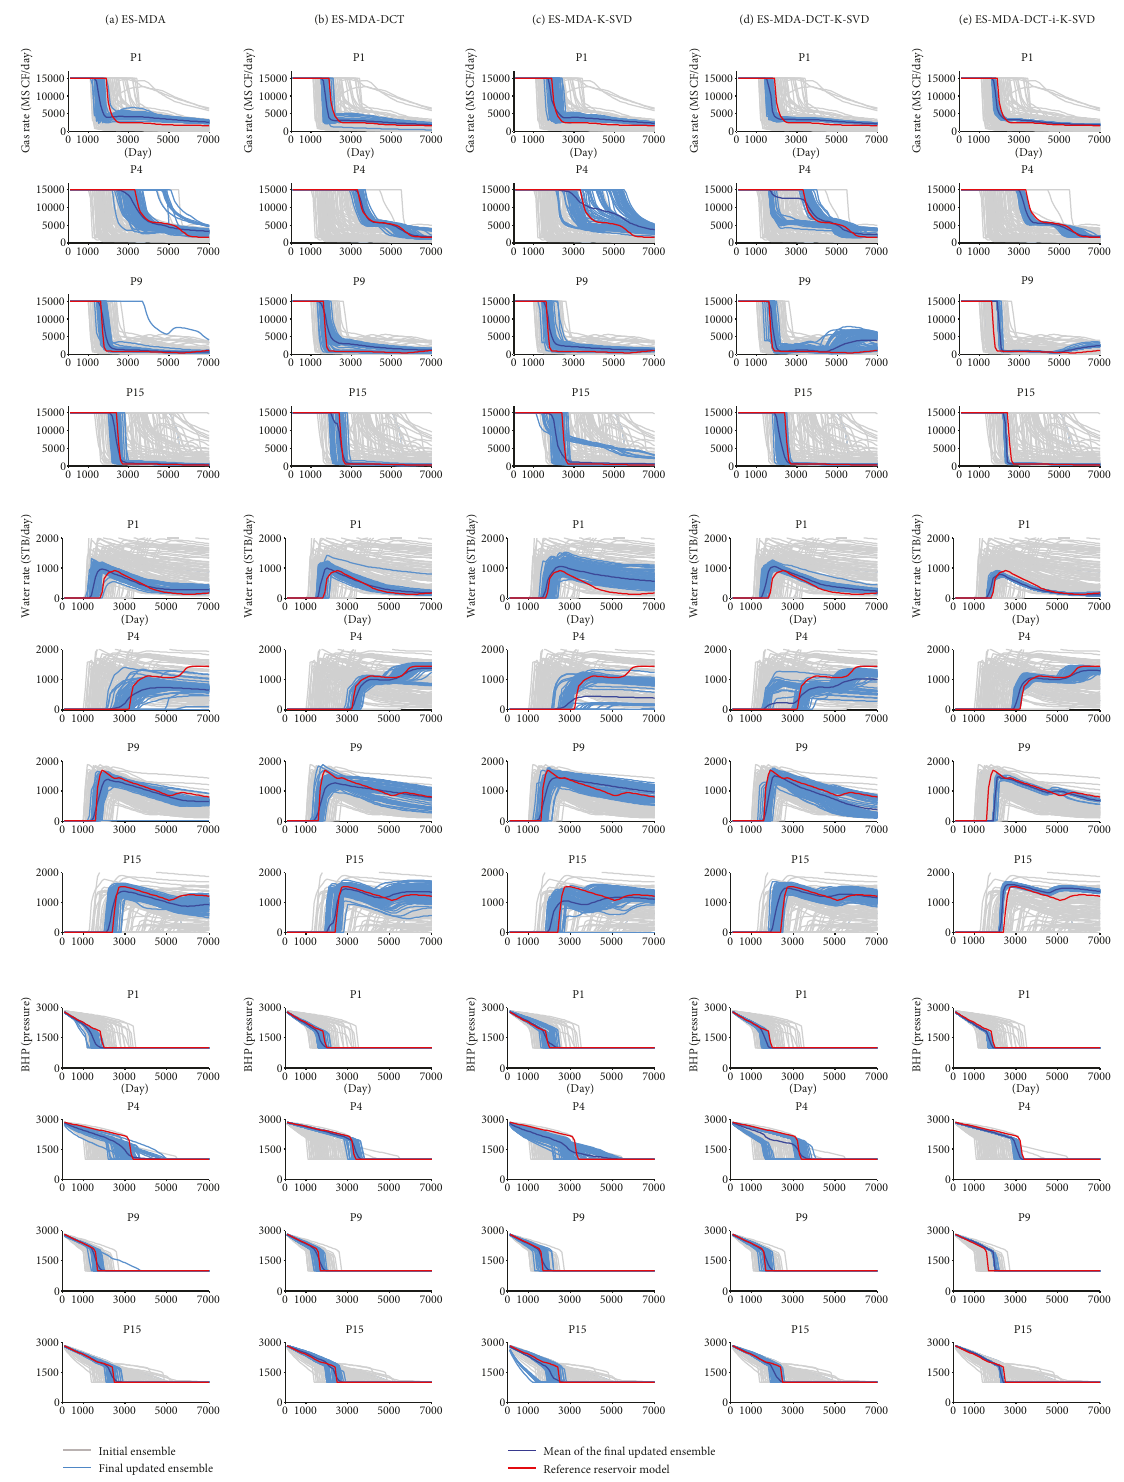
Figure 13: History matching results of Case 2: gas production rate, water production rate, and BHP measured at wells P1, P4, P9, and